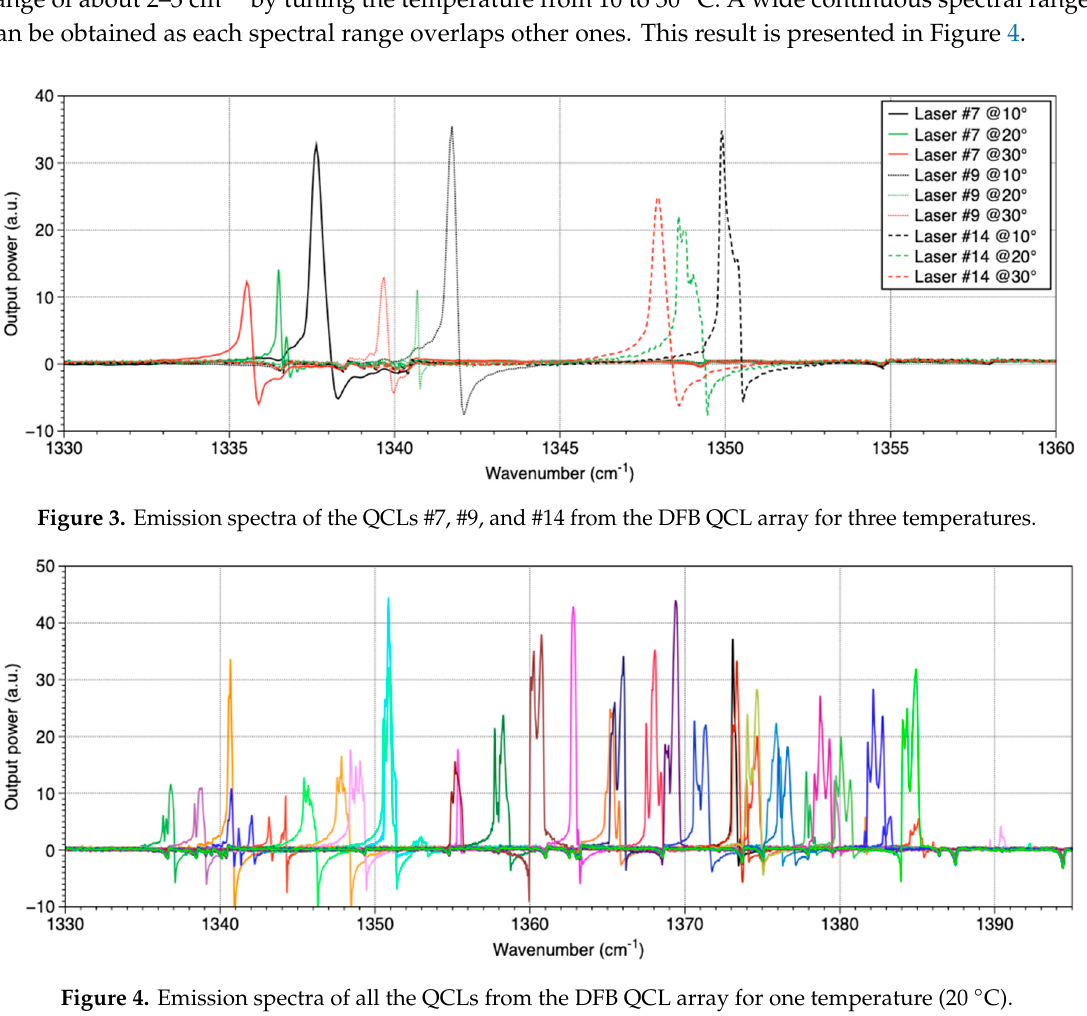
A total range of more than 50 cm − 1 from 1335 to 1387 cm − 1 can be achieved. Note that the FTIR used to record those spectra is not time-resolved and cannot be synchronized with the laser emission.